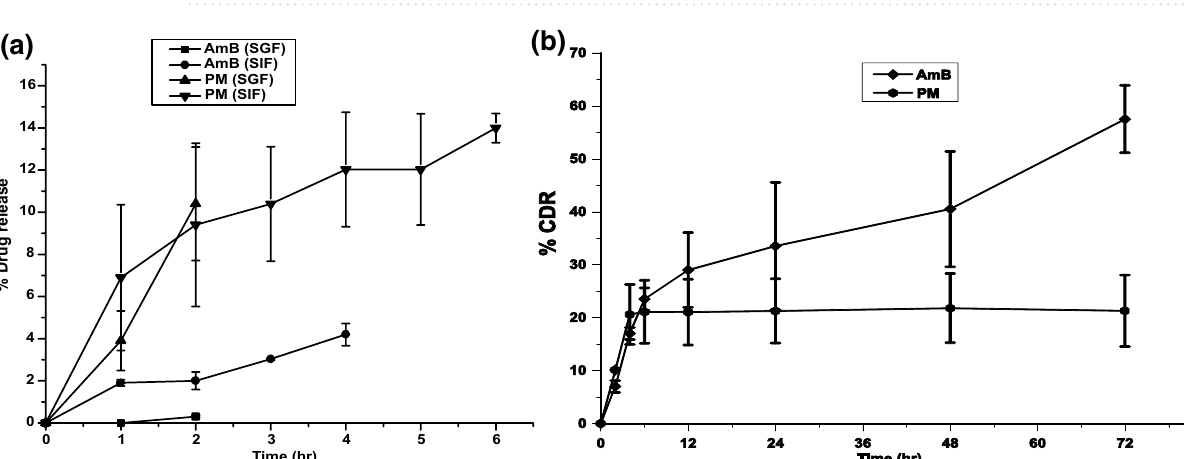
Figure 4. ( a ) In vitro release study in simulated gastric fluids (pH 1.6) and simulated intestinal fluids (pH 6.5) of m-DDSLNs. ( b ) In vitro release study of m-DDSLNs at pH 7.4. Results are presented as mean ± standard deviation (n =